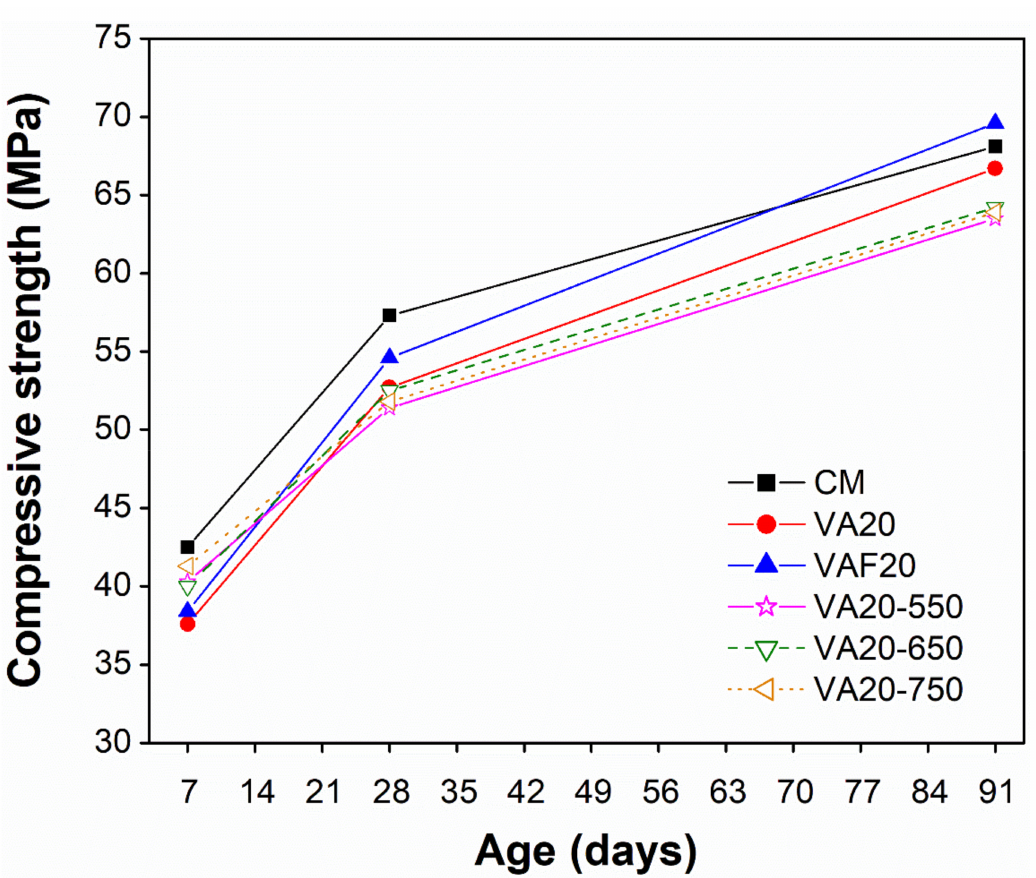
Figure 7. Comparison of compressive strength development between control and mortar containing VAF, and heat-treated and untreated